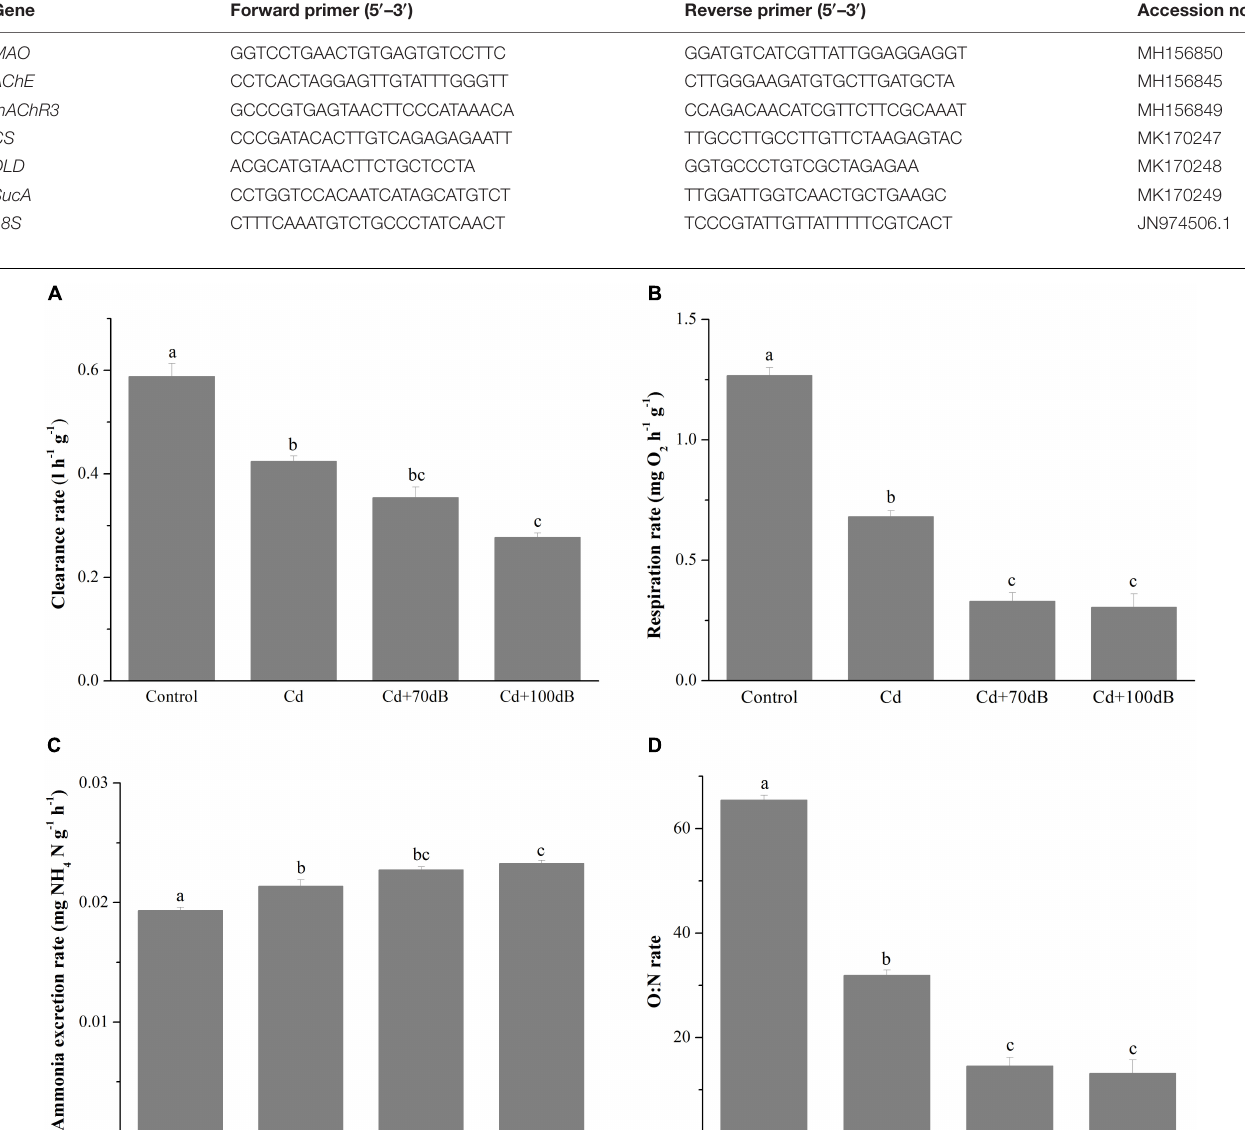
TABLE 3 | Primer sequences for the genes used in the real-time PCR analysis. Gene Forward primer (5 (cid:48) –3 (cid:48) ) Reverse primer (5 (cid:48) –3 (cid:48) ) Accession